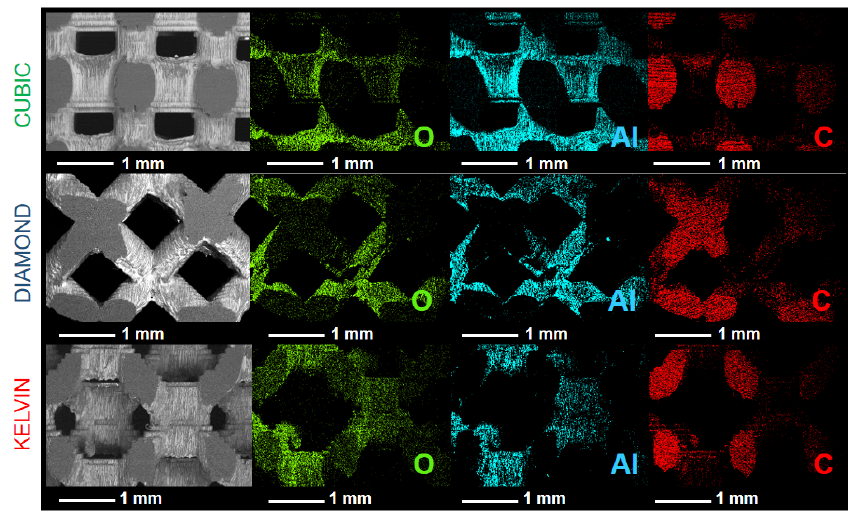
Figure 9. SEM micrographs of selected fragments of the different coated POCSs, including mapping of O, Al and C.